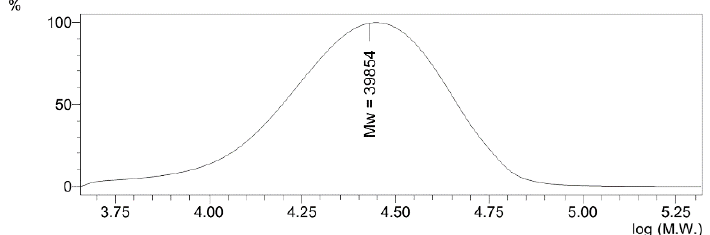
Figure 2. GPC traces of poly(VT-co-Na-VSA).